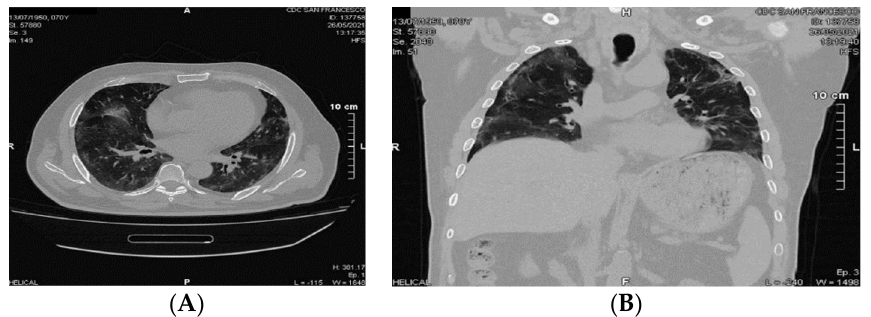
Figure 4. A 71-year-old male with sequel of COVID-19 pneumonia. Chest computed tomography (CT), axial image ( A ) showing bilateral peripheral areas of consolidation with surrounding ground- glass opacities (GGOs). Coronal image ( B ) showing bilateral peripheral area of interstitial thicken-